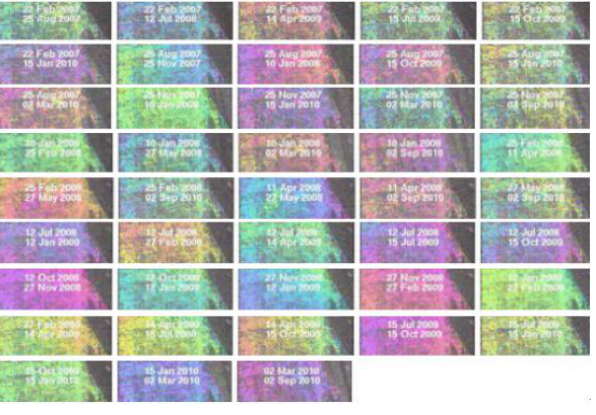
Figure 2. 43 interferograms In Fig.2, the interferograms are smoother without any large phase jumps, and the phase changes do not exceed one cycle. The multi-temporal coherent targets analysis method is